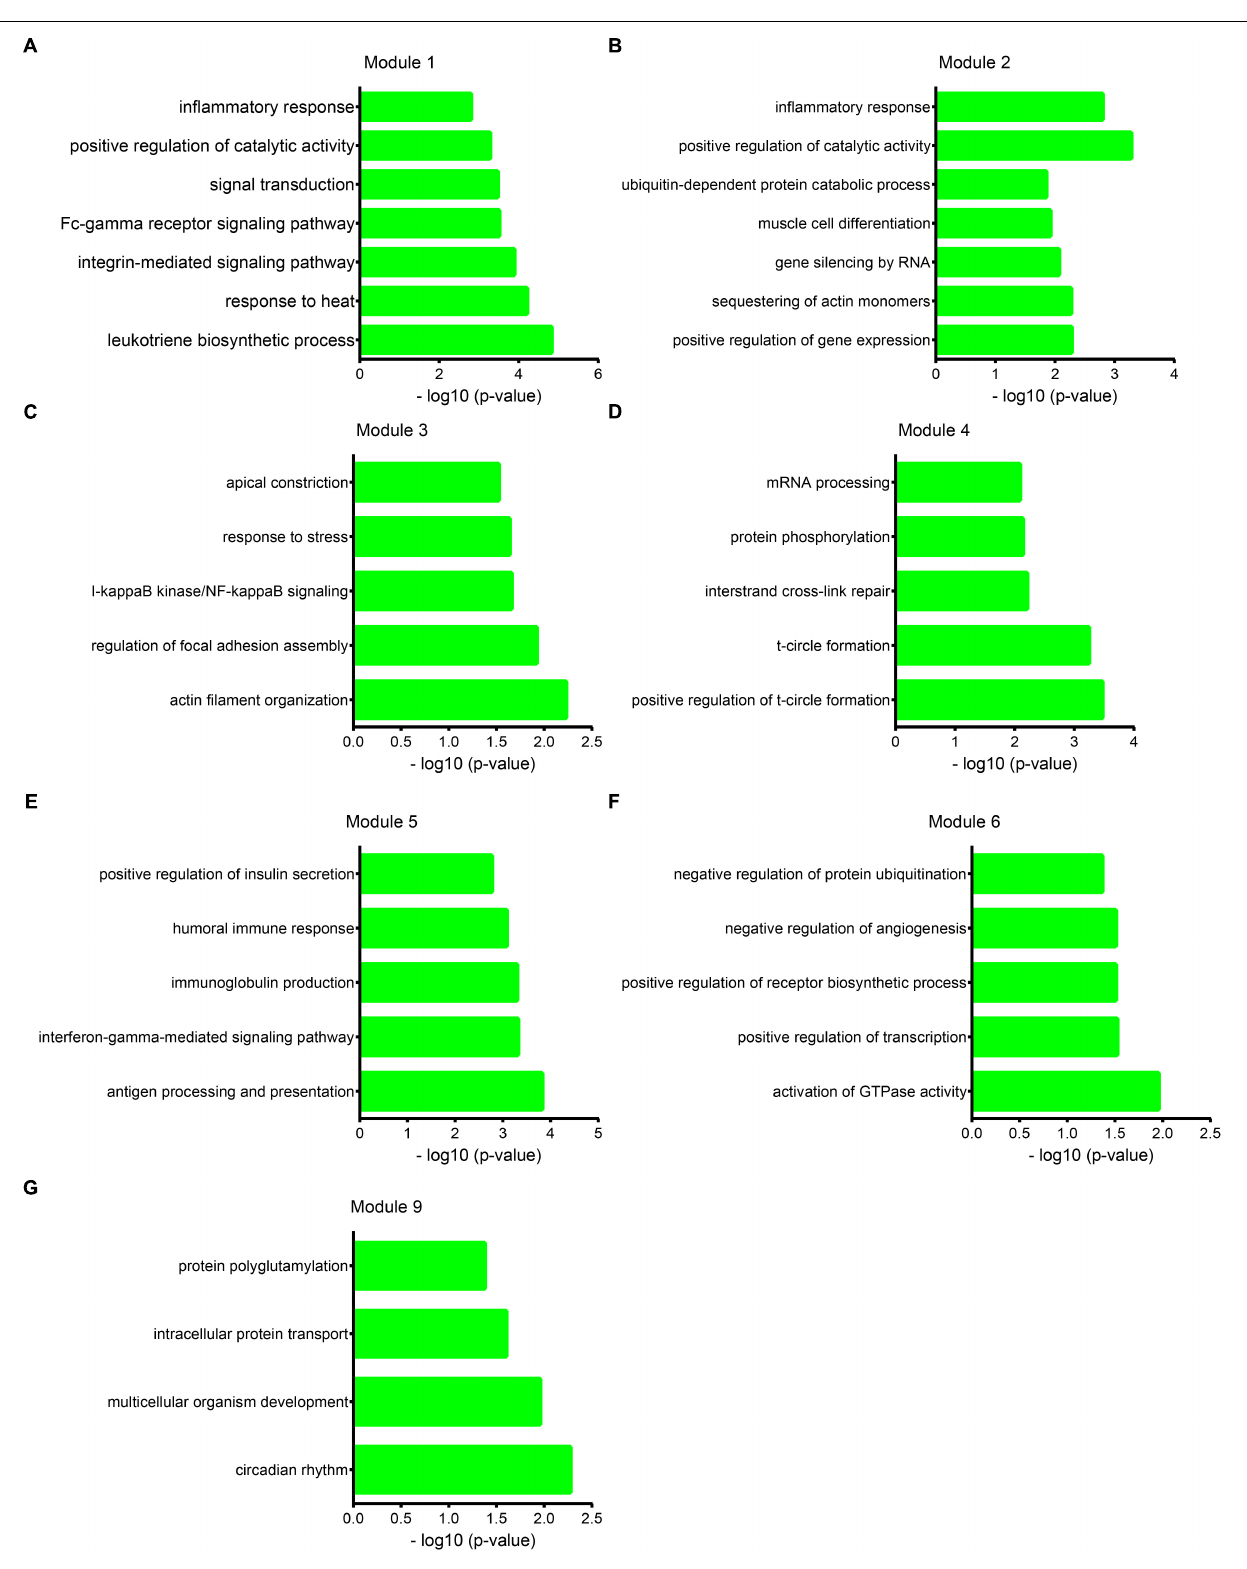
FIGURE 6 | Function annotation of atherosclerosis related lncRNAs. Gene Ontology (GO) analysis shows lncRNAs in module 1 (A) , module 2 (B) , module 3 (C) , module 4 (D) , module 5 (E) , module 6 (F) , and module 9 (G) regulate multiple biological processes.